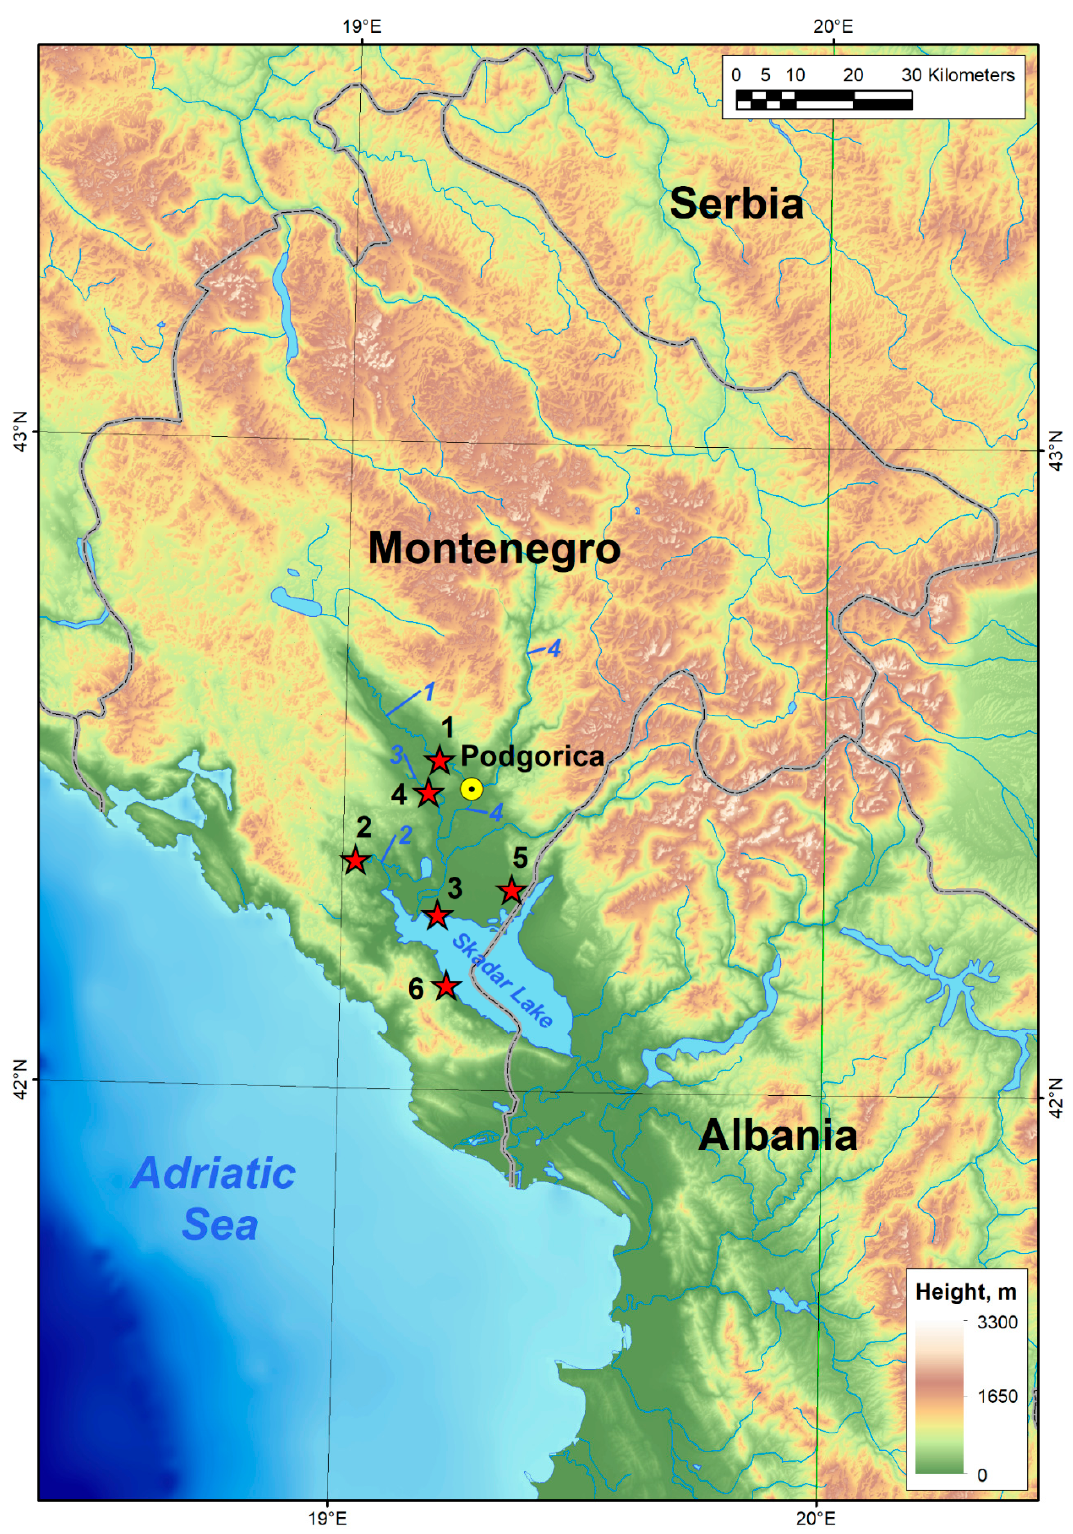
Figure 1. Map of Montenegro with our sampling localities. Red stars indicate studied sites: Zeta River ( 1 ); Crnojevica River ( 2 ); Plavnica River ( 3 ); Sitnica River ( 4 ); Skadar Lake (Podhum), site 1 ( 5 ); and Skadar Lake (Donji Muri ć i village), site 2 ( 6 ). Violet numbers indicate rivers: Zeta River ( 1 ); Crnojevi ć a River ( 2 ); Sitnica River ( 3 ); and Mora č a River ( 4 ).